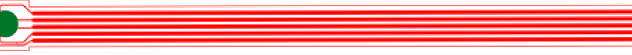
Figure 23. The prototype sensing system on a transfemoral amputee during the initial pilot trial.